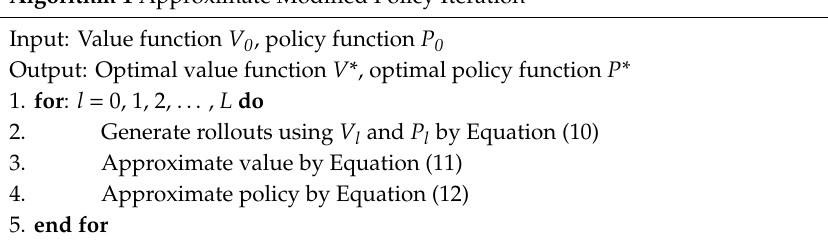
Algorithm 1 Approximate Modified Policy